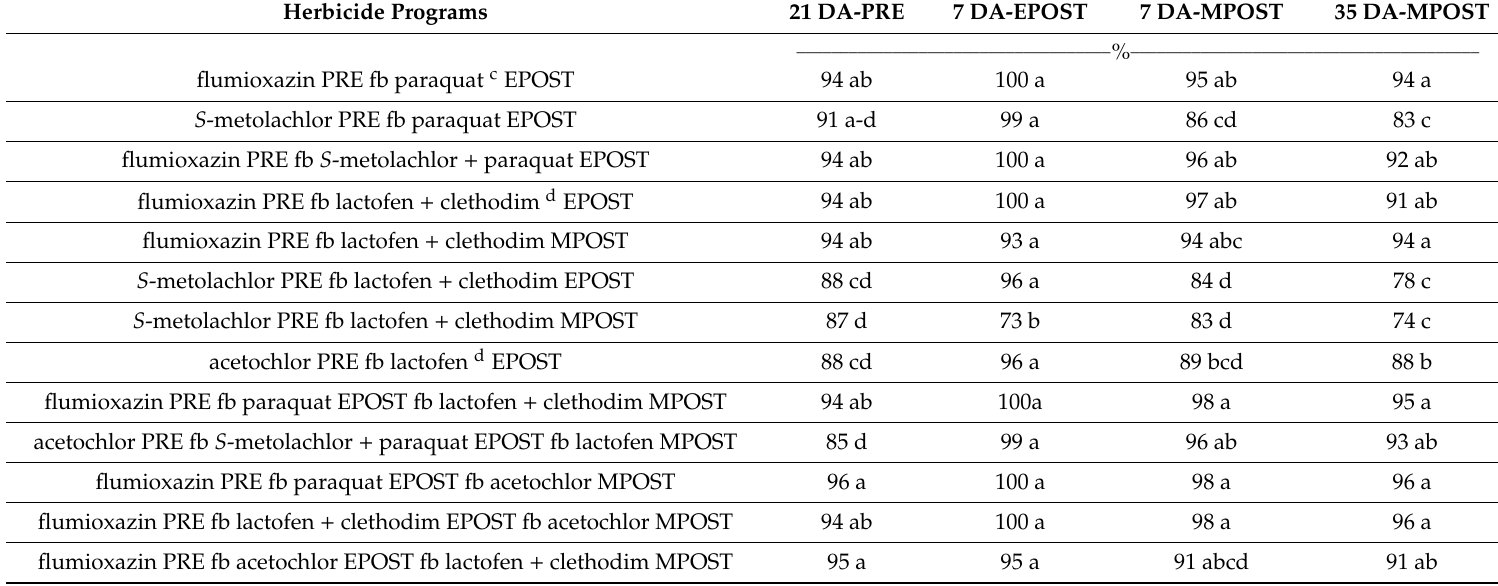
Table 5. Control of Palmer amaranth 21 DA-PRE, 7 DA-EPOST b , and 7 and 35 DA-MPOST b treatments in Weed Control Study at Stoneville, MS, averaged over 2017 and 2018 a